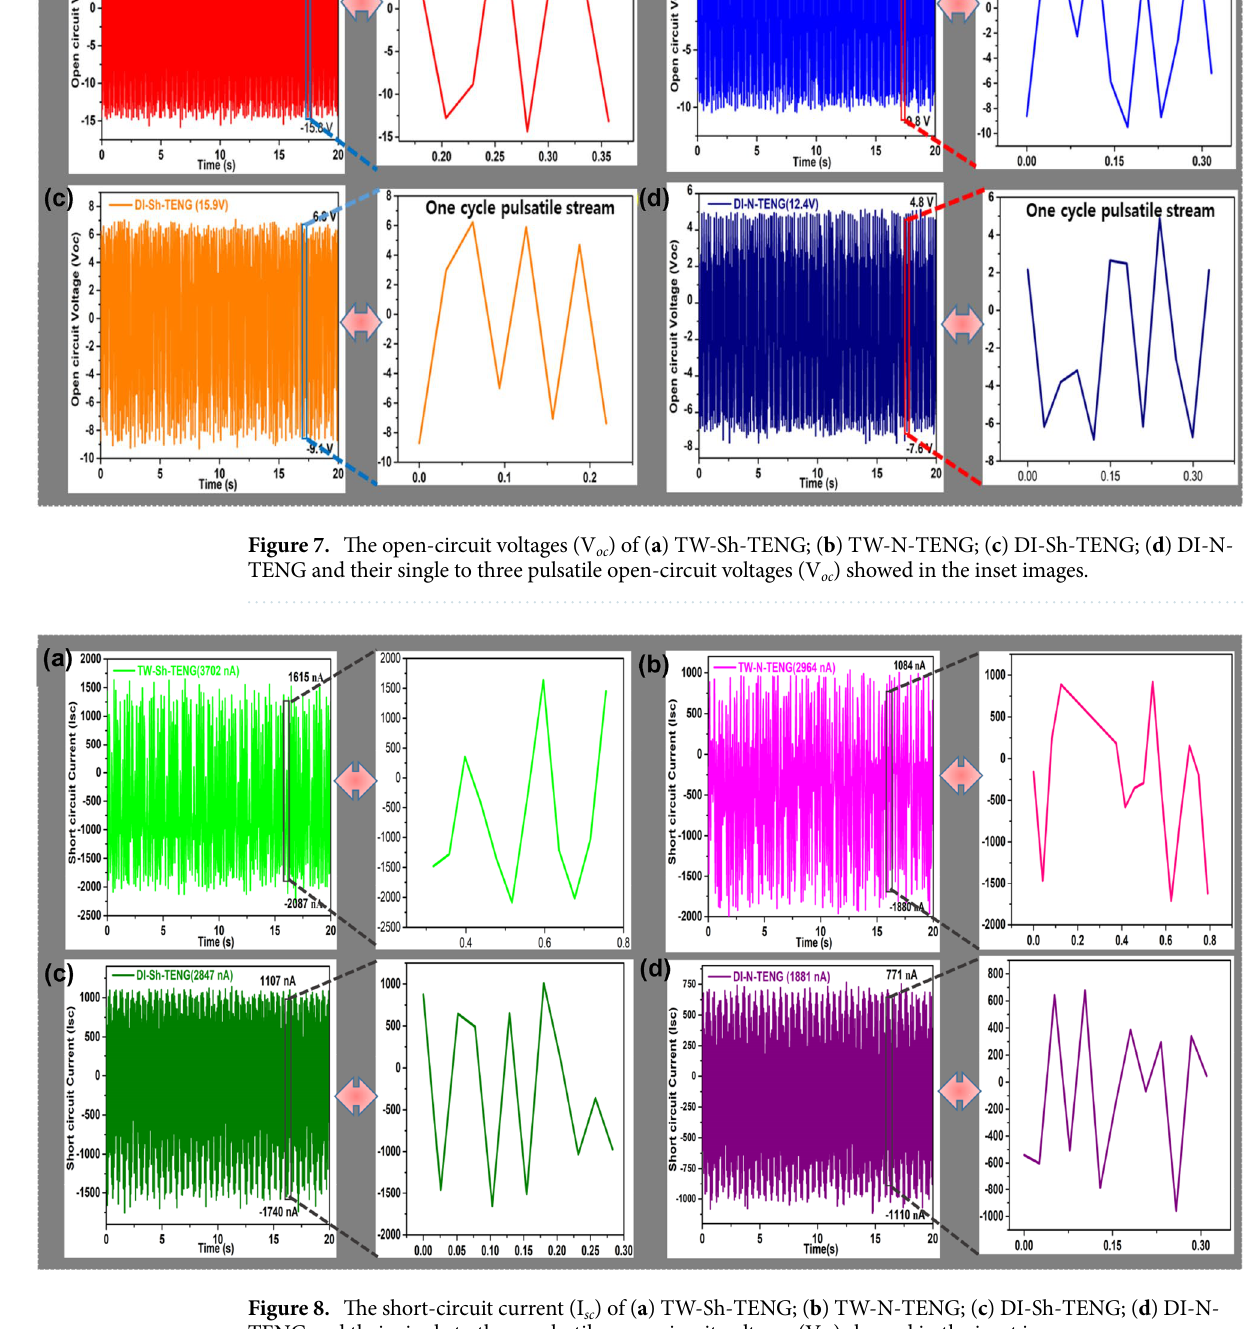
FT-IR, Diffraction data were acquired with a Rigaku high-power XRD. The images of the Multimode V AFM microscope (VEECO, US) were treated using a flattening algorithm in Nanoscope software, and the surface roughness average (Ra) was calculated using the instrument vendor’s software. A simple electric circuit was designed to evaluate the load features, and harvest performance of the liq- uid nanogenerator through flow TENGs. The circuit that includes with a full bridge rectifier, a capacitor for